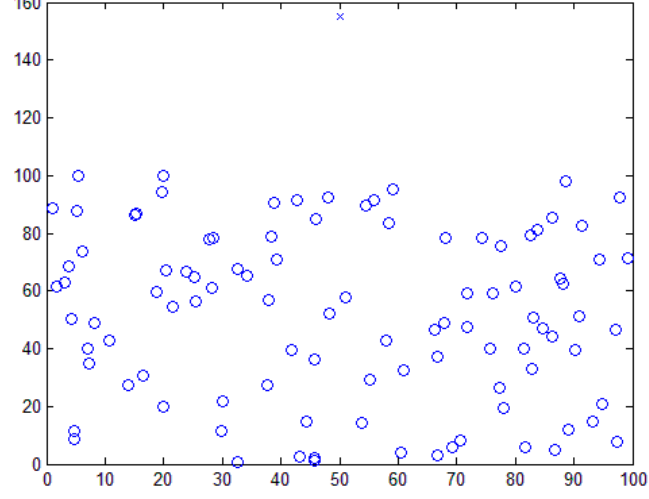
Figure 4. The initial deployment of the nodes when the BS is outside.